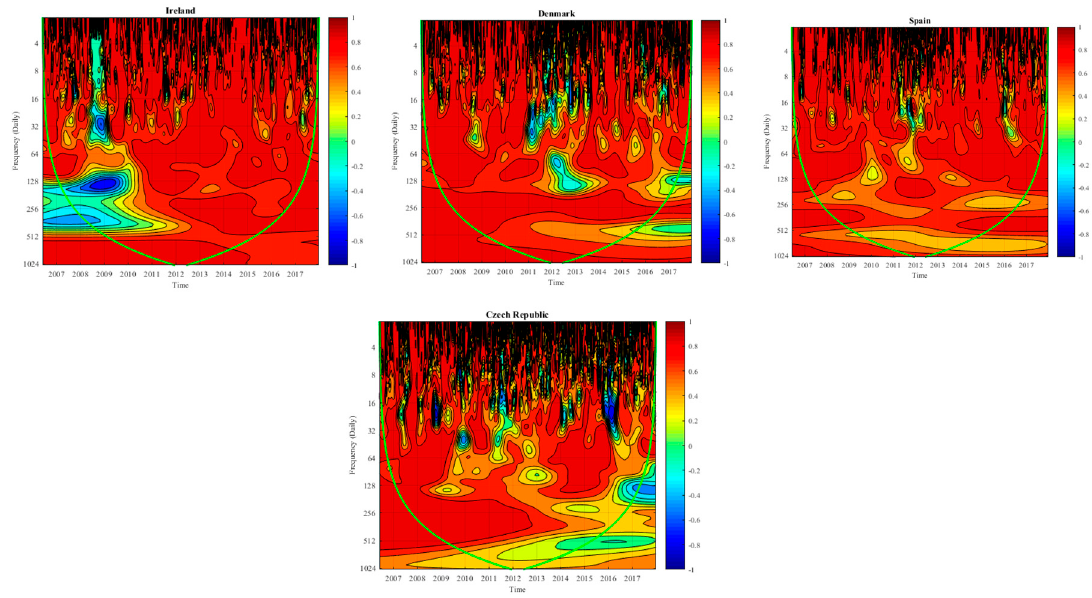
Figure 2. The European region’s Islamic-conventional stock returns wavelet correlations.